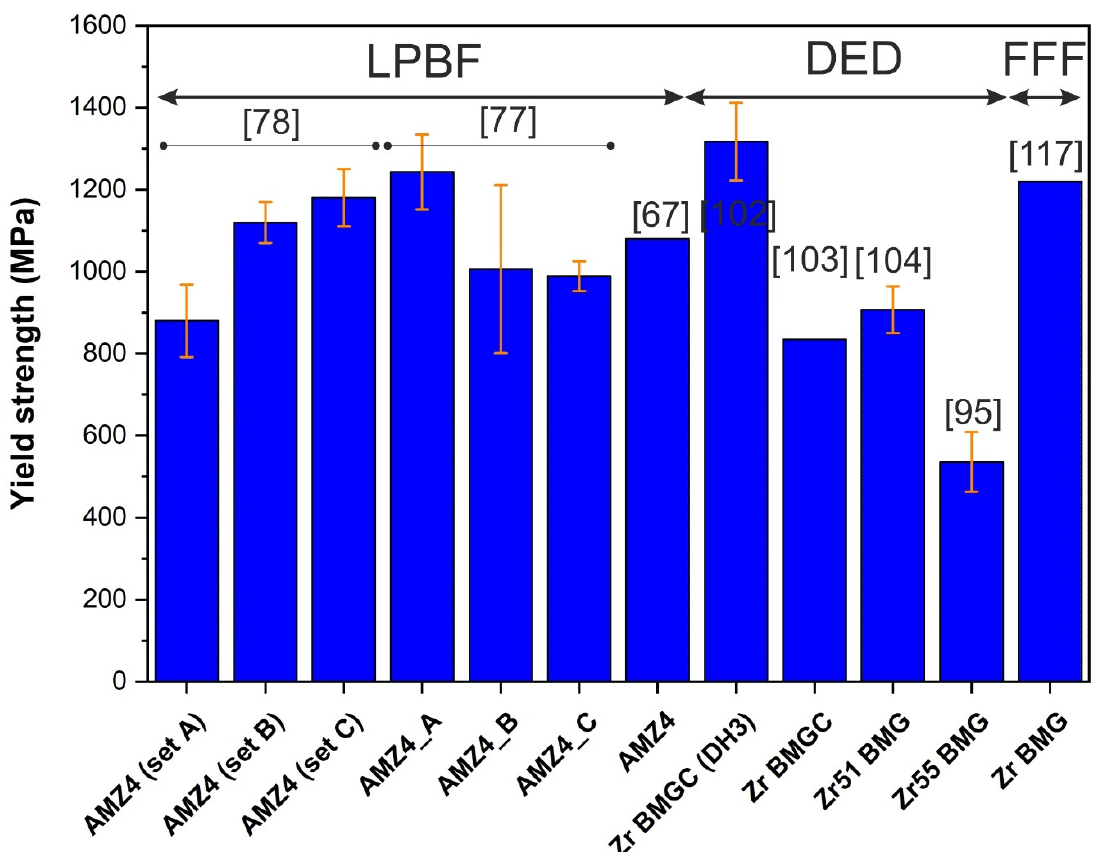
Figure 46. Comparison of reported tensile yield strengths of BMGs fabricated via AM. [67,77,78,95,102–104,117].